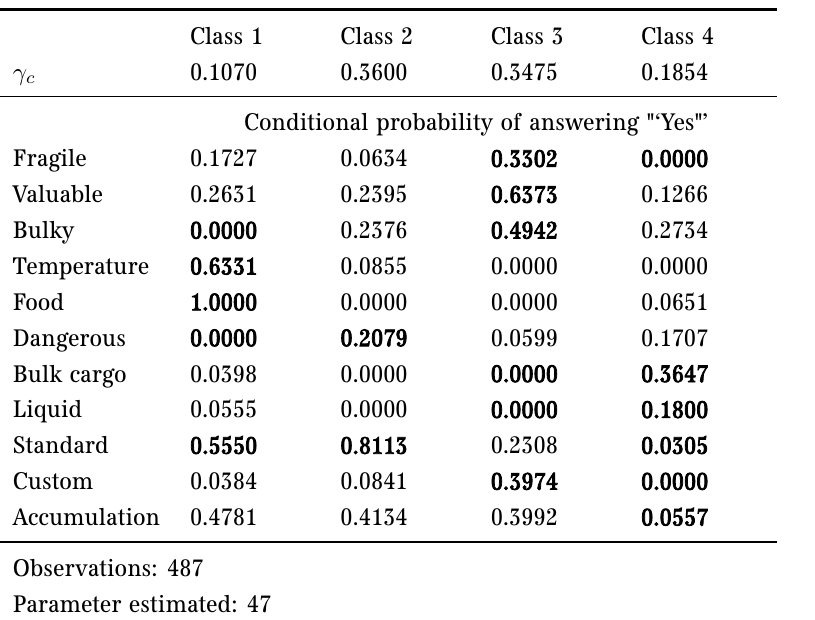
Table 11: Results of the LCA presented by Piendl et al.